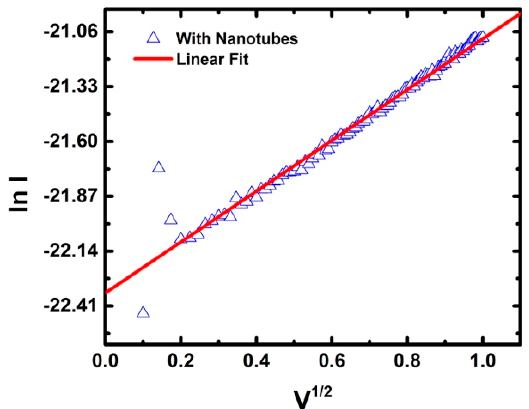
Figure 13. Fit for a Schottky barrier model for the average IV curve, from 0 to 1V.